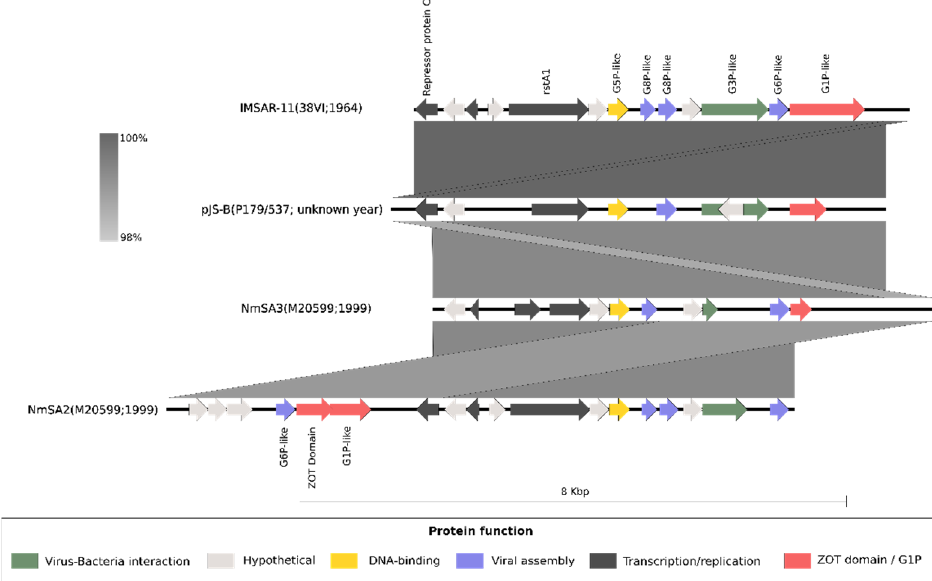
Figure 3. Prophage genome comparison among IMSAR-11 members. The strain name of the bacterium host and the isolation year are indicated in parentheses. Colors for genes are based on the analysis of HHpred [23]. The shaded lines (in grey) depicts nucleotide similarities between the sequences. NmSA2 and NmSA3 were found in the same genome of M20599 (GCA_001407225.1; PubMLST id: 31322; Chile). The reverse complement of pJS-B (NC_004758.1; Norway) and NmSA2 are depicted. IMSAR-11 of 38VI (BioSample: SAMEA678244; PubMLST id: 349; the United States), pJS-B, and NmSA3 are circular forms, whereas NmSA2 is flanked by chromosomal regions in the N. meningitidis genome.